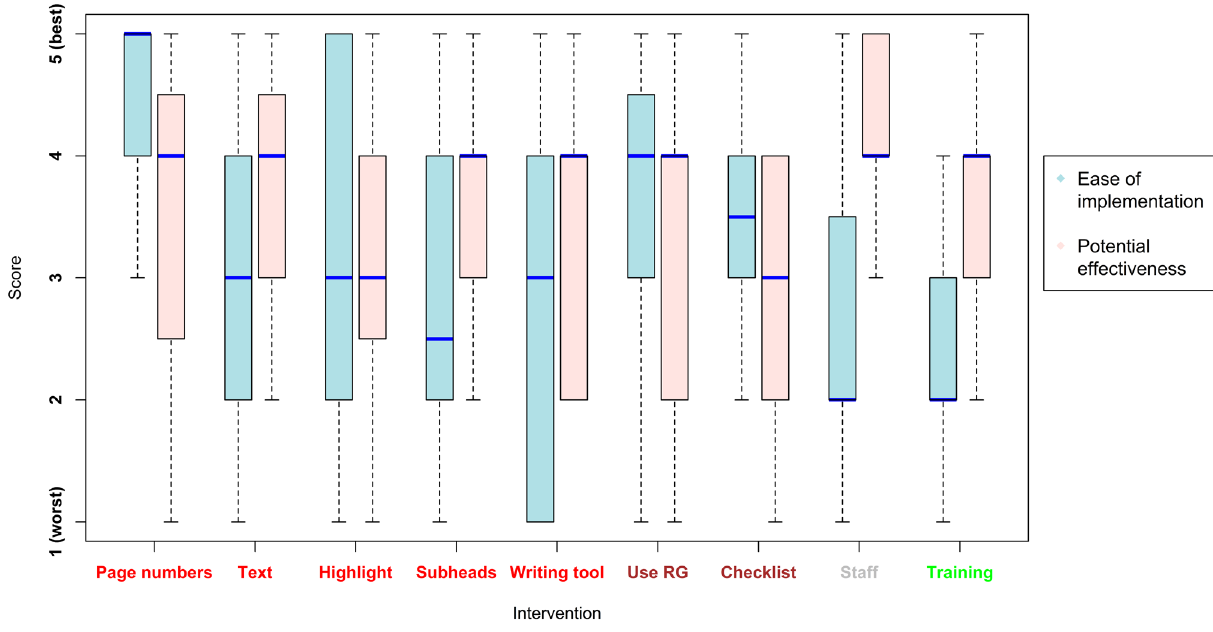
Figure 1. Scores for perceived ease of implementation and perceived effectiveness. Box plots show the 1 st , 2 nd (medians, represented as blue horizontal lines), and 3 rd quartiles of the data. The whiskers extend up to 1.5 times the interquartile range from the top (bottom) of the box to the furthest datum within that distance. Interventions whose names are shown in red target authors, those in brown target peer reviewers, the one in grey target editors or administrative staff and the one in green targets all these stakeholders. Box 1 shows a detailed explanation of each